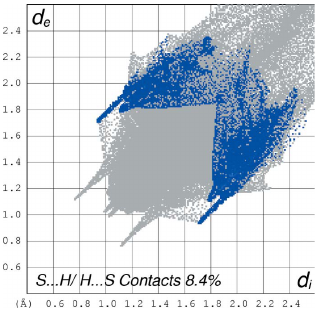
Figure 6 The two-dimensional fingerprint plot for the title compound depicting the contribution percentage of S (cid:2)(cid:2)(cid:2) H